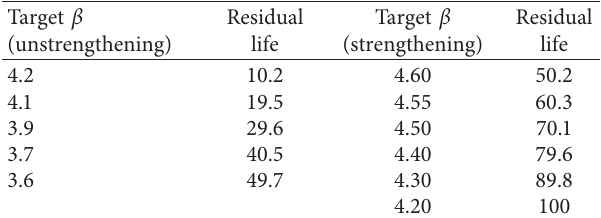
Figure 5: Influence of vehicle load variation coefficients of reli- ability index. Table 6: Life estimation based on the target reliability index.